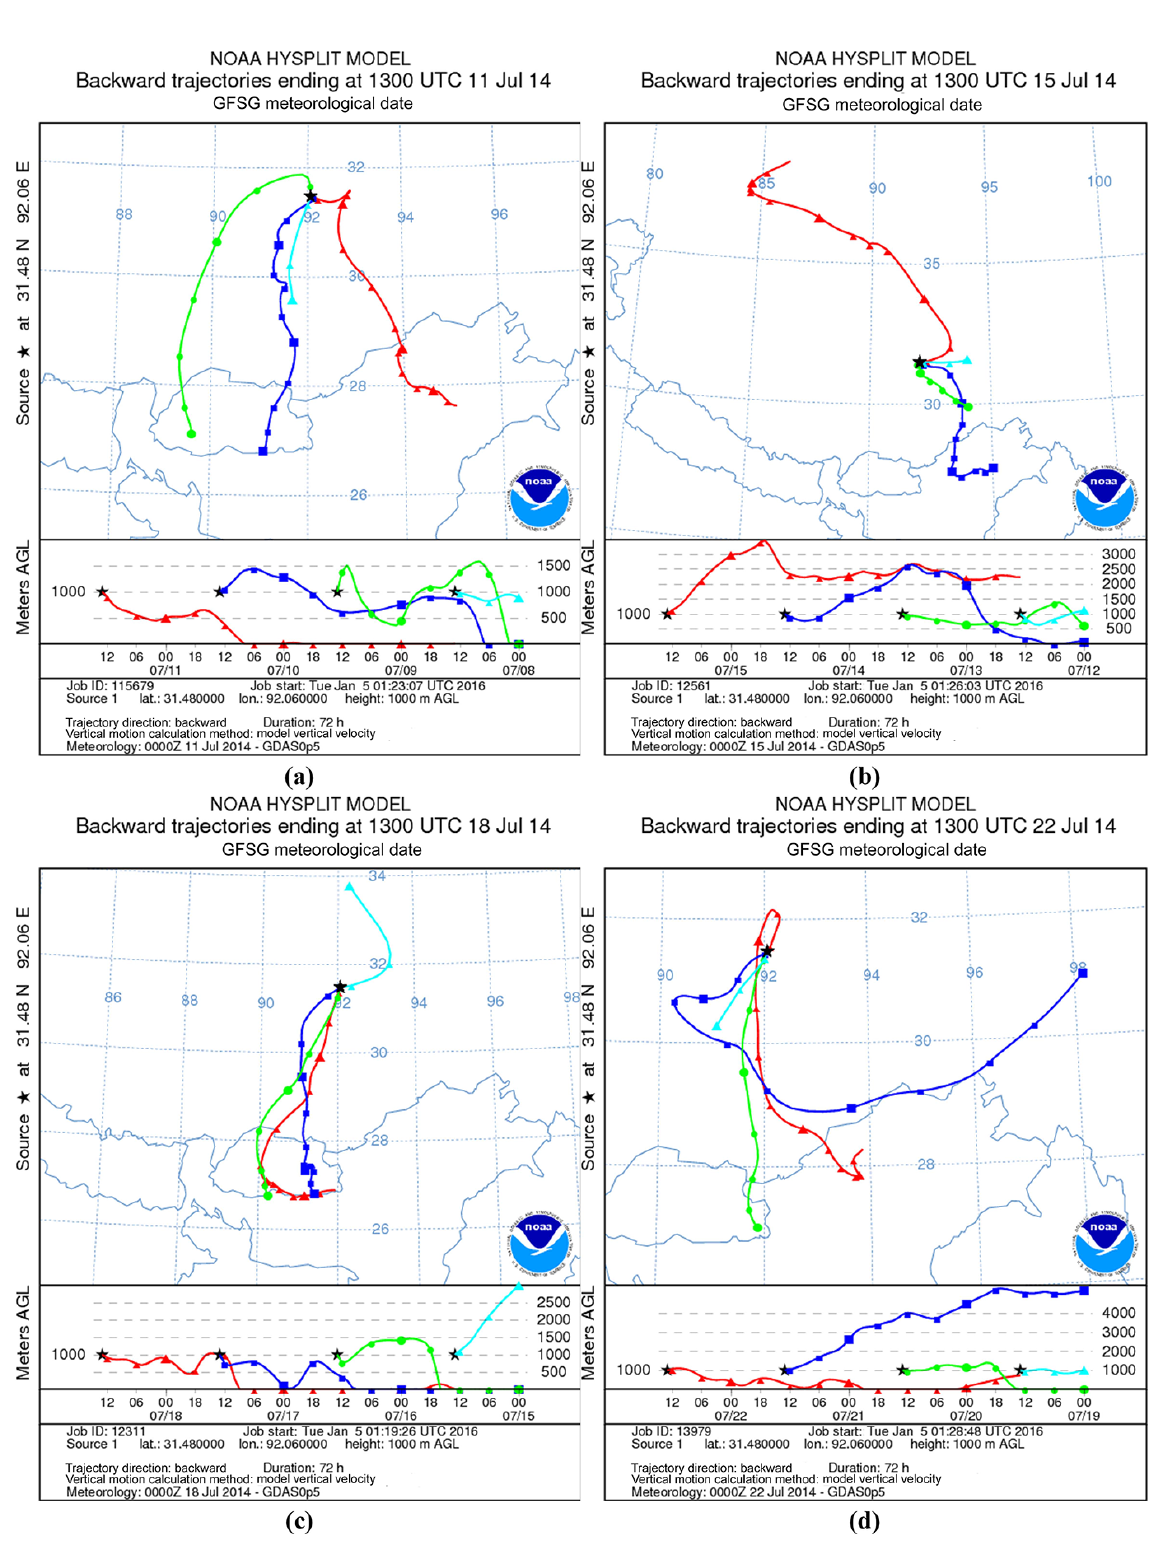
Figure 7. Backward trajectories ending at 21:00 LST on (a) 11, (b) 15, (c) 18 and (d) 22 July 2014, simulated by the HYSPLIT model.